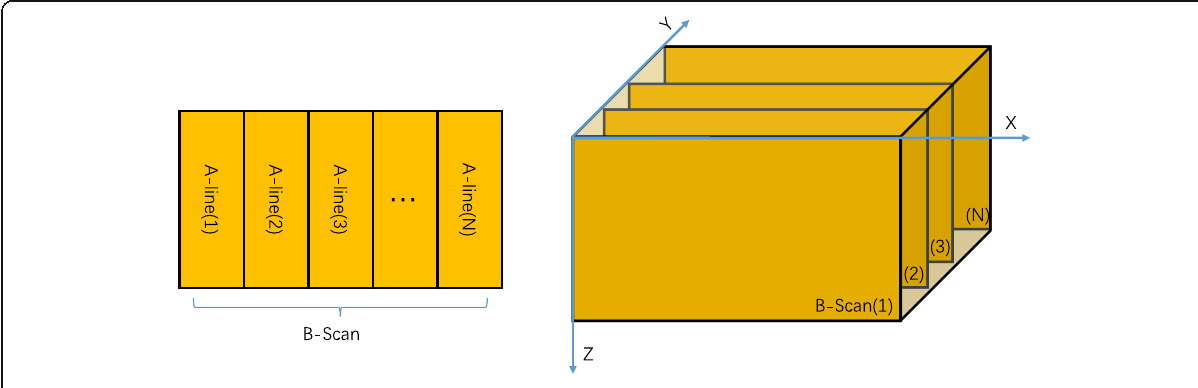
Fig. 2 ( a ) B-scan data structure and ( b ) overall data